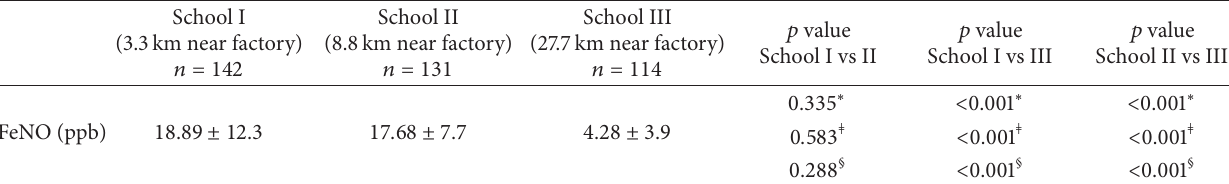
Table 2: The comparison of FeNO value among Schools I, II,